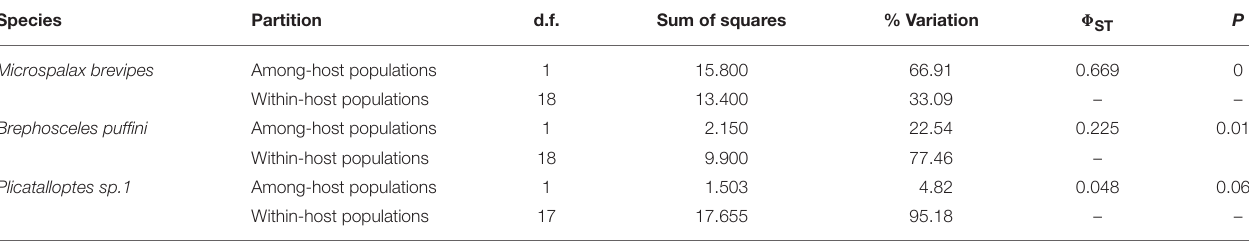
TABLE 4 | Analysis of molecular variance (AMOVA) on mitochondrial haplotypes partitioned by seabird host. Species Partition d.f. Sum of squares %